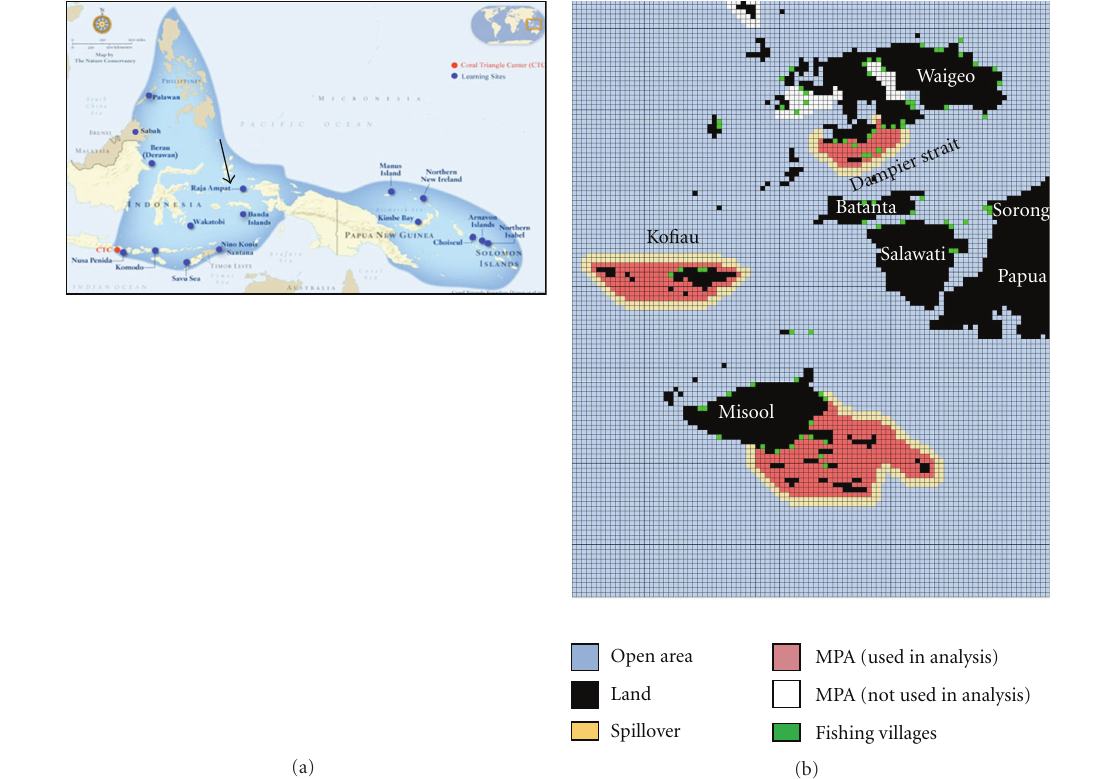
Figure 1: (a) Location of Raja Ampat in the coral triangle (source: The Nature Conservancy Coral Triangle Center http://www.coraltri- anglecenter.org/en/page/coral-triangle). The blue shaded region shows the boundary of the coral triangle and the arrow points to the location of Raja Ampat; (b) MPA boundaries. The figure shows the names and boundaries of the three MPAs on which the study is based (pink), spillover regions (yellow), fishing villages (green), and MPAs not part of the analysis (white). Each cell in the map is approximately 2.56 x 2.57 km. The city of Seram mentioned in the text is located on mainland Papua towards east of Misool.